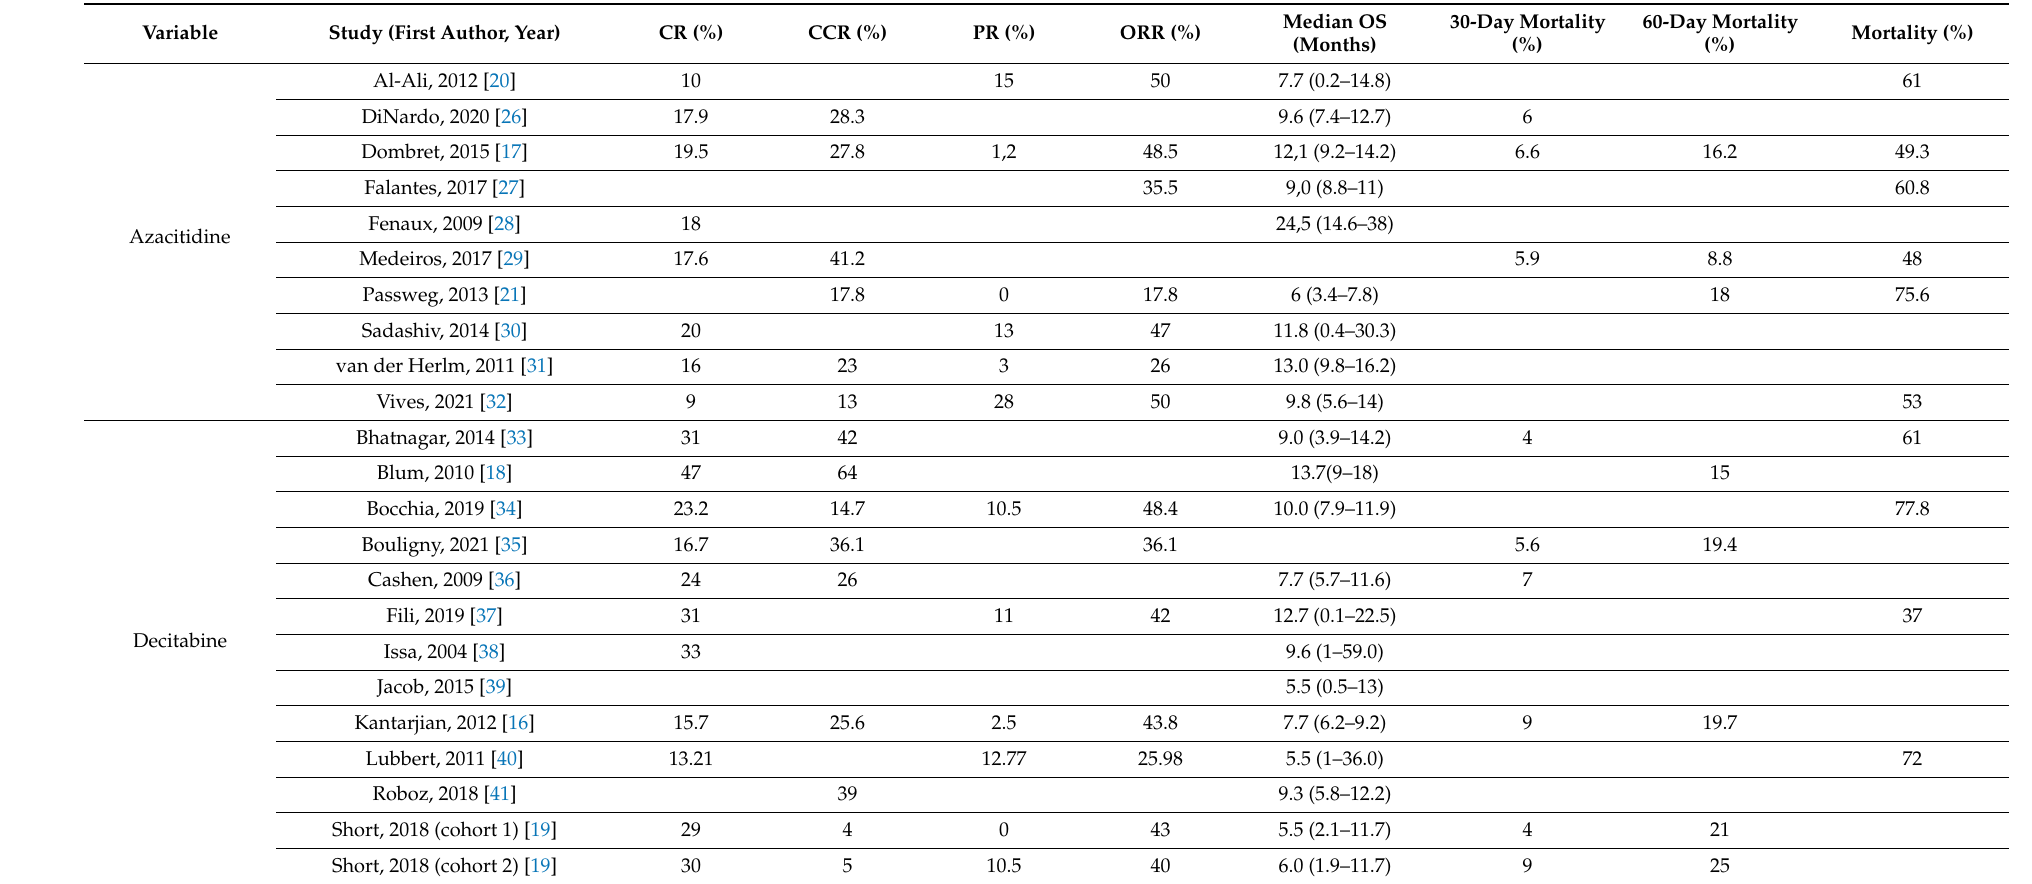
Table 2. Efficacy outcomes of the studies included in the